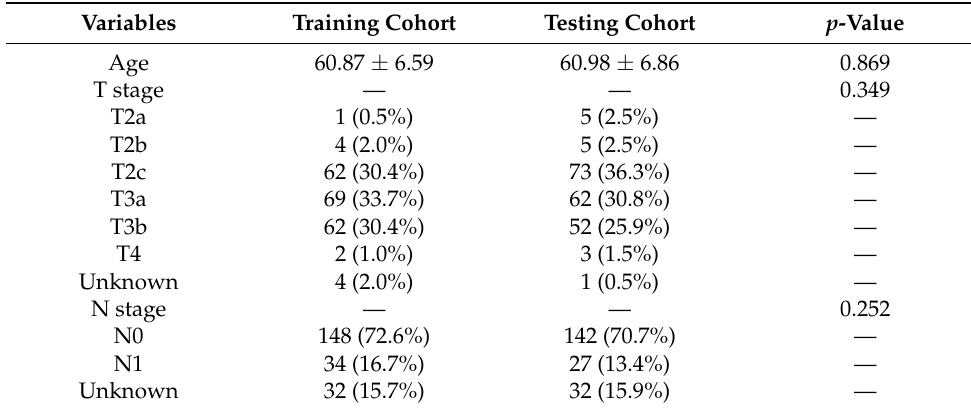
Table 1. The basis data of training cohort and testing